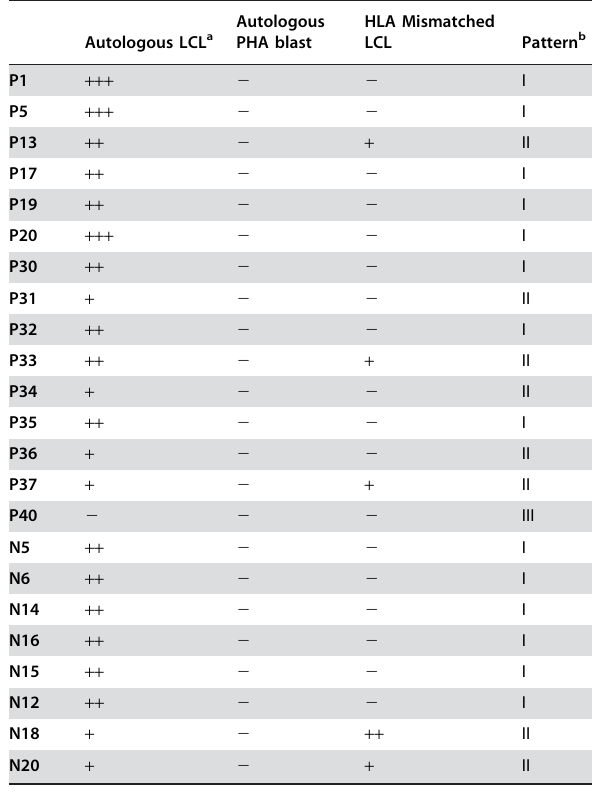
Autologous LCL a